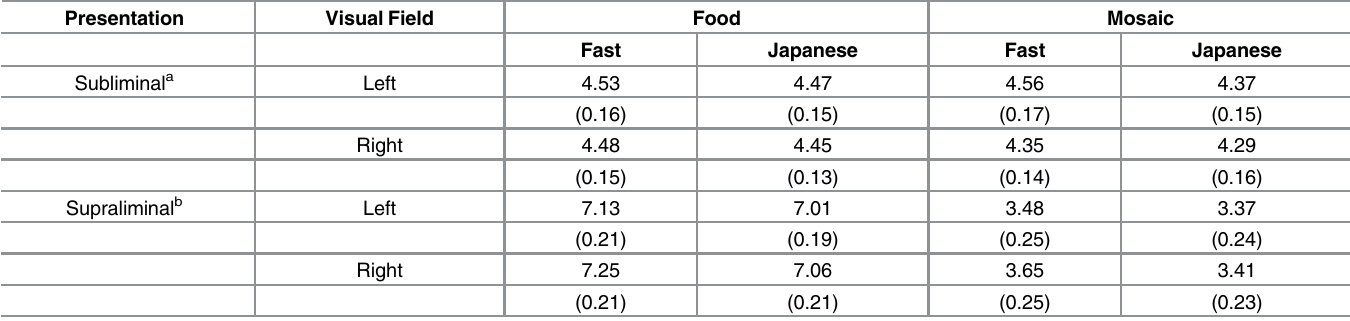
Table 1. Mean (with SE ) preference ratings.